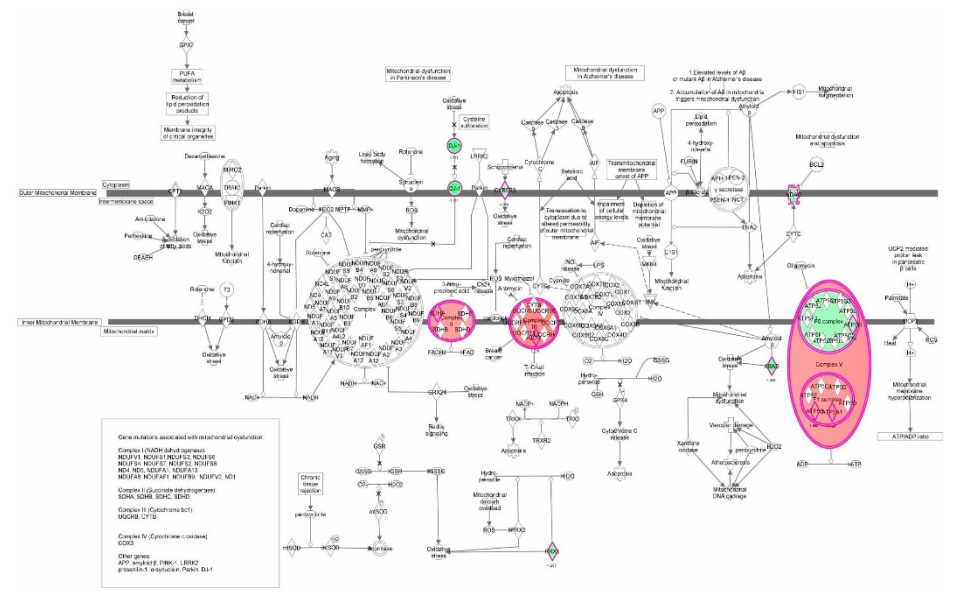
Figure 31. Mitochondrial dysfunction was induced by vancomycin in HK-2 cells. HK-2 cells were treated with 50 µ g/ml vancomycin for 24 h and the protein samples were subject to quantitative proteomic analysis. Red indicates an up-regulation; green indicates a down-regulation. The intensity of green and red colors indicates the degree of down- or up-regulation. Solid arrow indicates direct interaction and dashed arrow indicates indirect